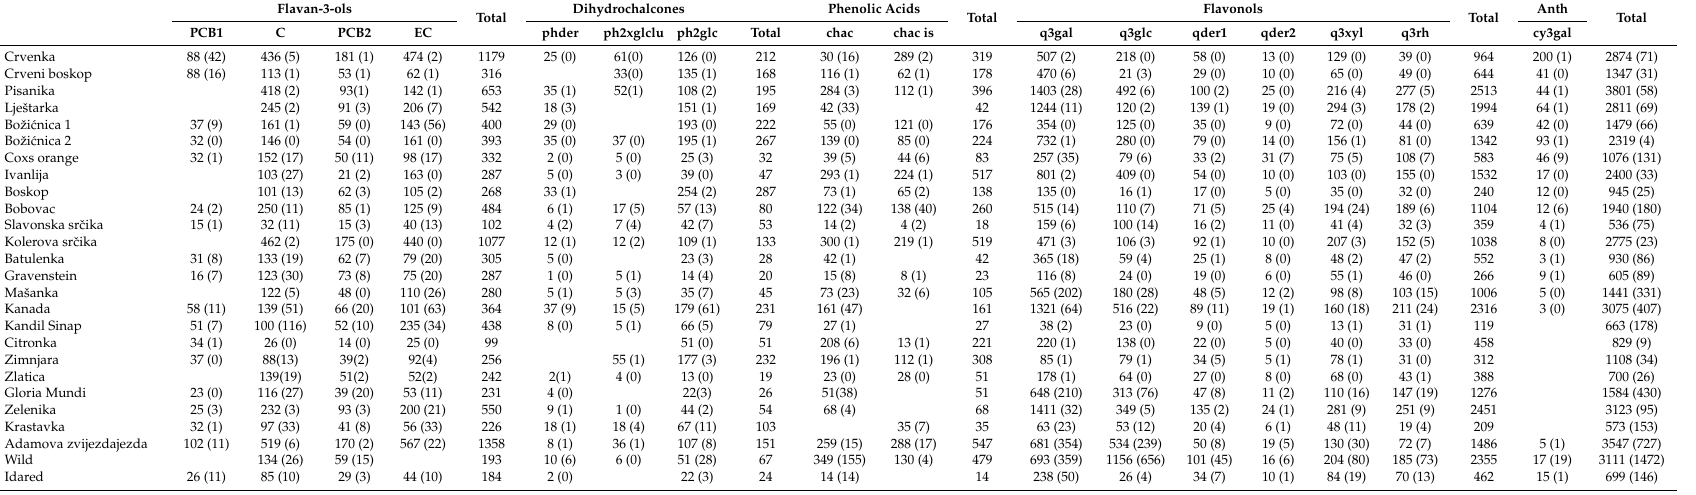
Table 2. The amount of polyphenols in the peel of old apple varieties (mg kg − 1 fresh